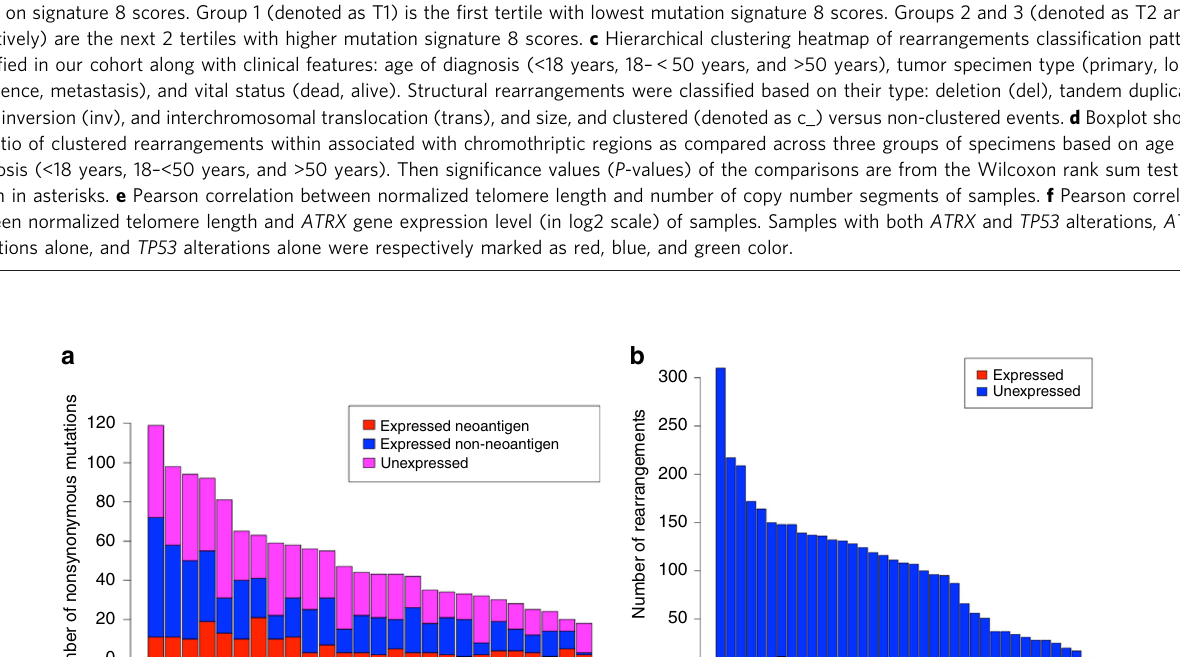
Fig. 2 Expressed neoantigens and rearrangements. a Stacked bar chart for number of nonsynonymous mutations and neoantigens detected by WGS and capture-based RNASeq. (expressed neoantigen: nonsynonymous mutations found in both WGS and capture-based RNASeq that are predicted to be a neoantigen; expressed non-neoantigen: nonsynonymous mutations found in both WGS and capture-based RNASeq that are not predicted to be a neoantigen; unexpressed: found in WGS only). b Overlapping rearrangements between WGS and RNASeq based rearrangements where both partners are within coding regions (unexpressed: found in WGS only; expressed:found in both WGS and